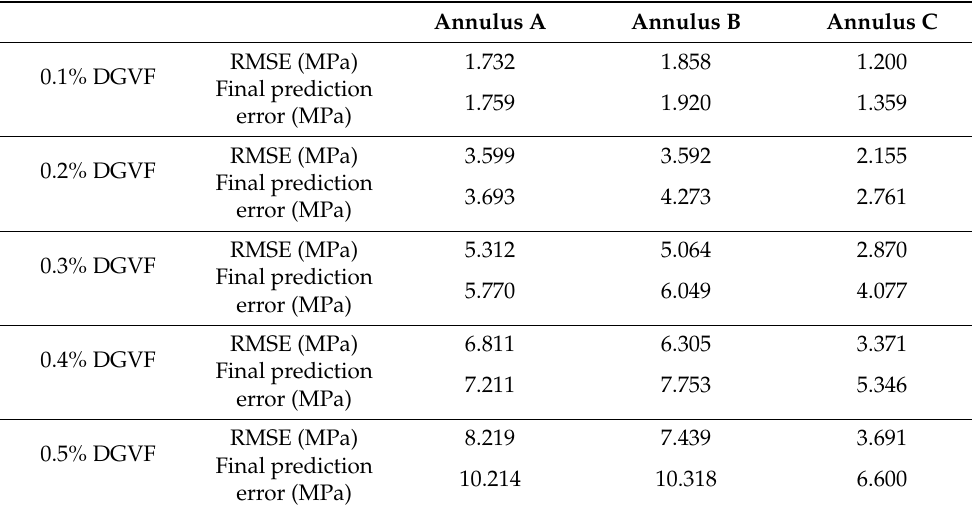
Table 7. The deviation between the results under different dissolved gas volume fraction and no dissolved gas.